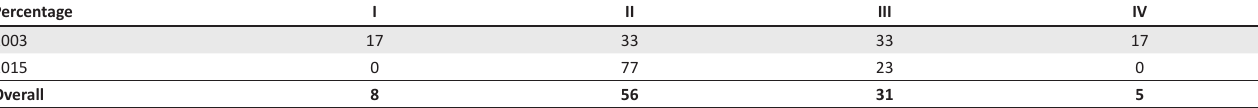
TABLE 5: A typology of South African Journal of Human Resource Management contributions: 2003 and 2015. Percentage I II